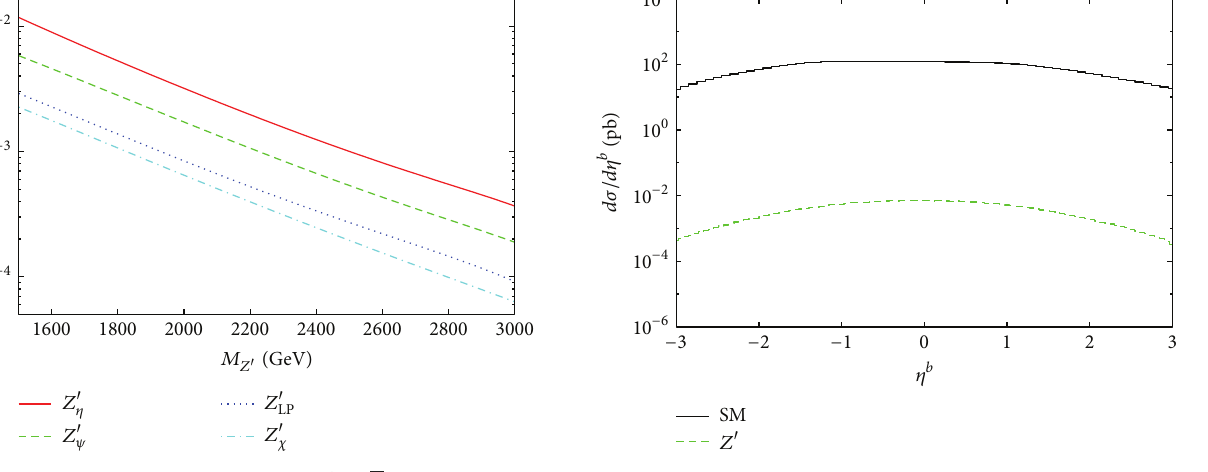
Figure 14: The invariant mass distribution of the ( 𝑊 + 𝑏𝑡 + 𝑊 system for the SM and 𝑍 󸀠 𝜂 model with different mass values of 𝑍 󸀠 boson at the LHC with √𝑠 = 13 TeV. The results are obtained for = 700 GeV. 𝑥 = 0.1 and 𝑚 𝑡 󸀠